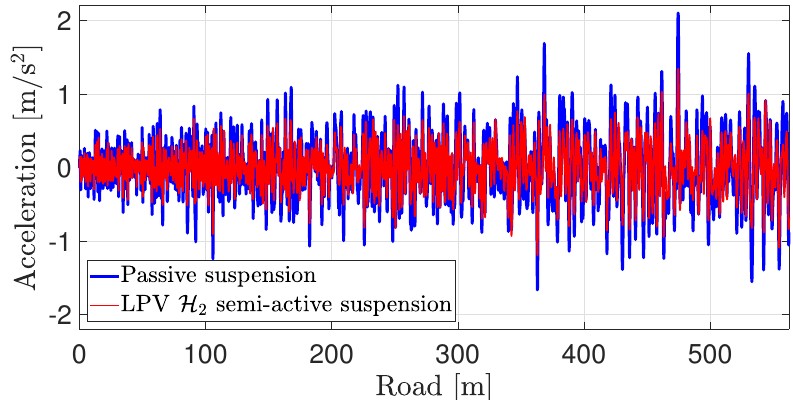
Figure 15. Sprung mass acceleration at the front right corner (filtered by (14)).